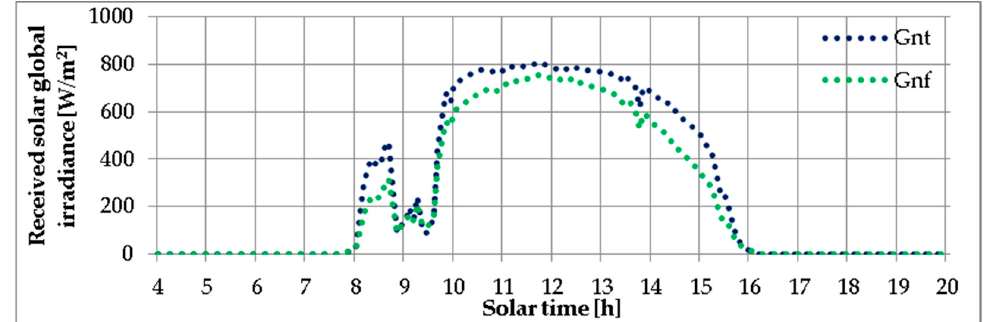
Figure 15. Solar global irradiance received by the tracked ( G nt ) and fixed ( G nf ) PV platforms on 23 December 2021.